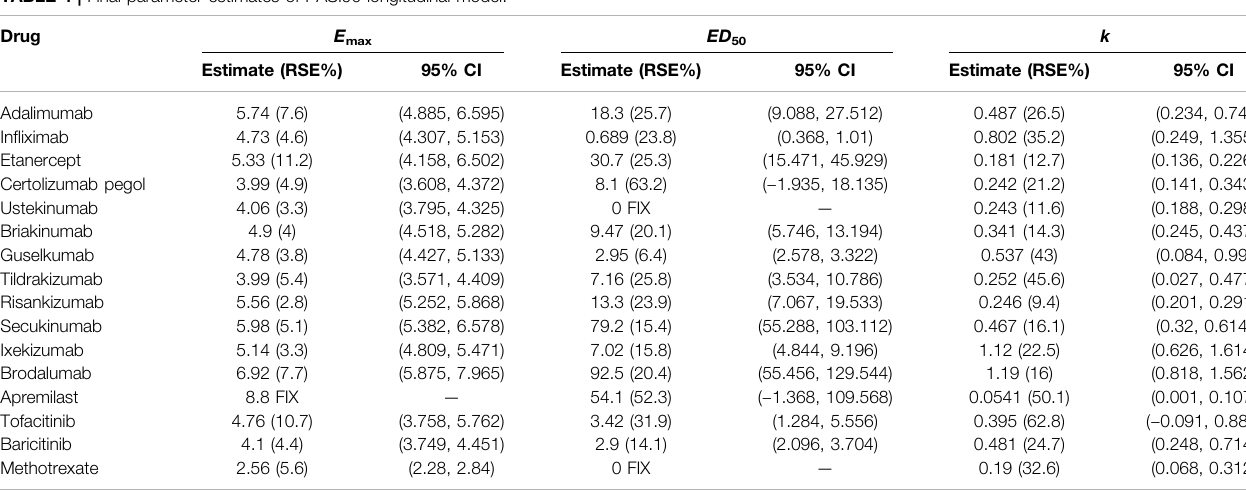
TABLE 4 | Final parameter estimates of PASI90 longitudinal